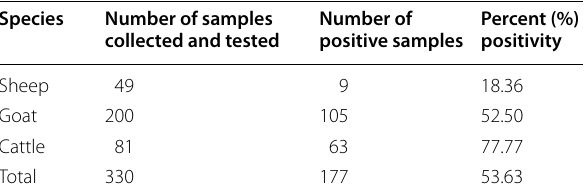
Table 7 Seroprevalence